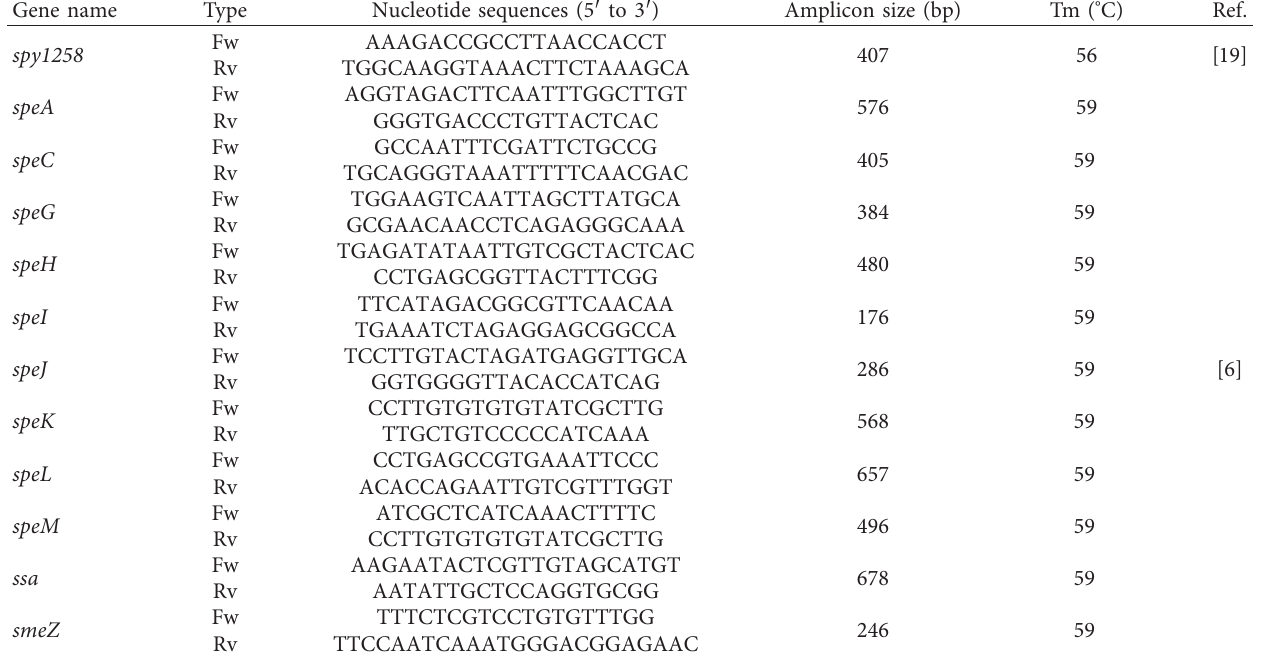
Table 1: Different oligonucleotides used in this work to detect different S. pyogenes genes. Gene